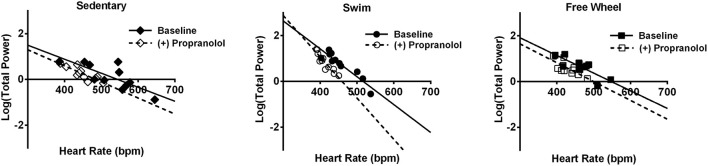
Relationship between TP HRV and HR before and after propranolol. In the absence of propranolol, linear regression analyses of the relationship between the logarithm of the TP HRV and the HR, revealed that HRV decreased exponentially for both sedentary and exercised mice with the dependence being somewhat steeper (P < 0.054) for the swim exercised mice (n = 11, slope = −0.012 ± 0.0016, r = 0.93) vs. free-wheel (n = 11, slope = −0.0077 ± 0.0018, r = 0.82) and sedentary mice (n = 11, slope = −0.0061 ± 0.0016, r = 0.78). Propranolol administration caused an increased, albeit non-significant (P = 0.054), dependence of TP HRV on HR in swim exercised mice (slope = −0.018 ± 0.0024, r = 0.93), driven by a reduction in the range of HR values following SNA blockade. No change in the relationship was observed in free-wheel (P = 0.86) or sedentary (P = 0.68) mice following propranolol administration showing that HRV is not highly dependent on HR independently of PNA. No change (P > 0.12) in the intercept was observed in any group. The nature of the relationship did not change in the presence or absence of HR correction (data not shown).